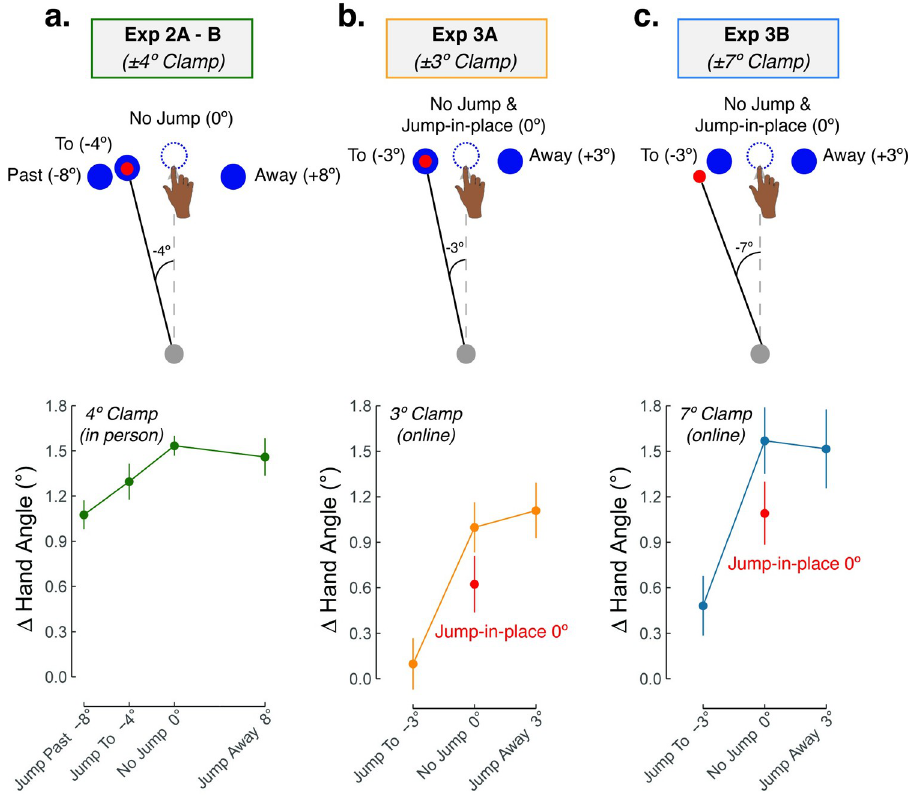
Fig 5. Implicit recalibration is modulated by TE in the presence of SPE (Exp 2–3). (a)–(c) Participants experienced a randomized zero-mean perturbation schedule where both clamp size (Exp 2, in-person: ± 4˚ clamp; Exp 3, online: ± 3˚ or ± 7˚) and target jump size (Exp 2 range: -8 to 8; Exp 3 range: -3 to 3) were varied. A positive change in hand angle signified recalibration in the expected direction, by flipping the sign of hand angles in response to counterclockwise (+) clamped feedback and clockwise (-) target jumps. Dots represent mean and vertical lines represent SEM.